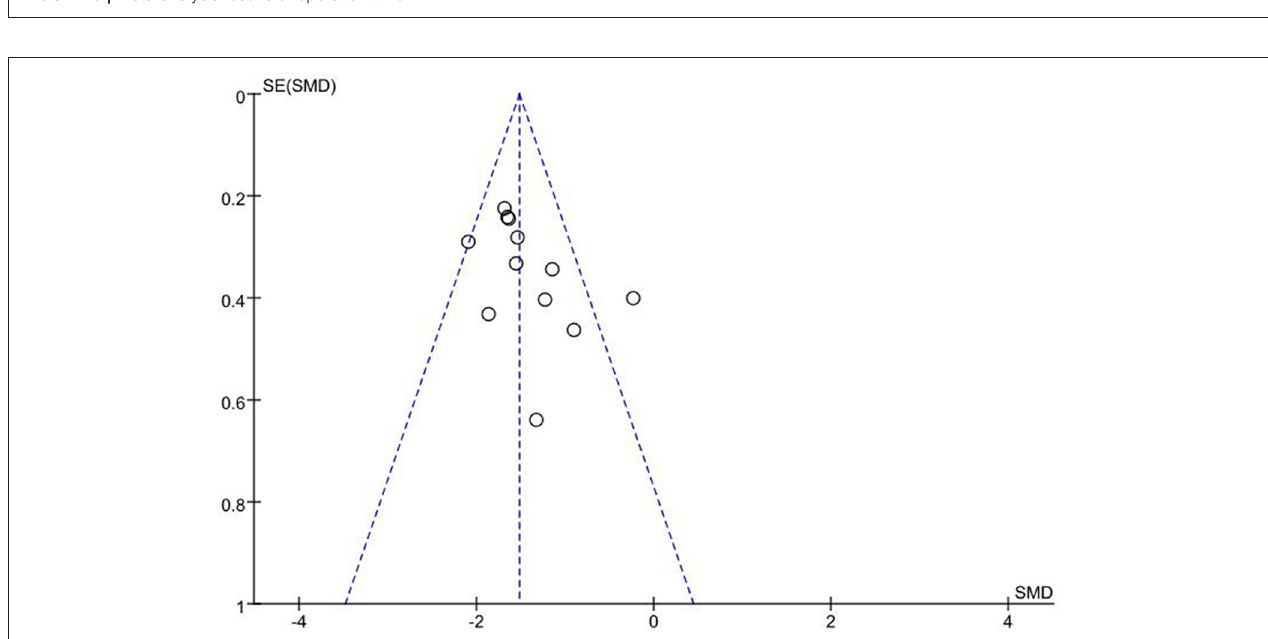
FIGURE 4 | Funnel plot of included